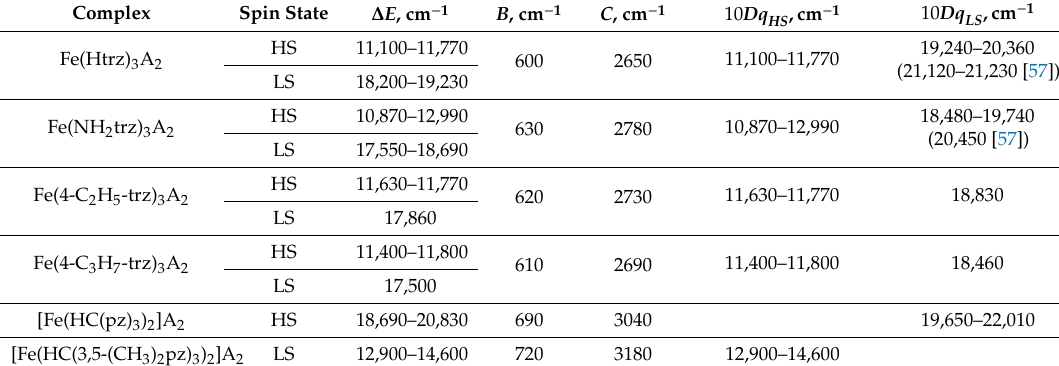
Table 4. Splitting parameters for HS- and LS-complexes of iron(II) with 1,2,4-triazoles and